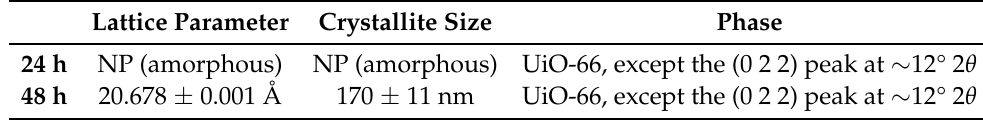
Table A1. Phase summary of SO 3 H-UiO-66(Zr).